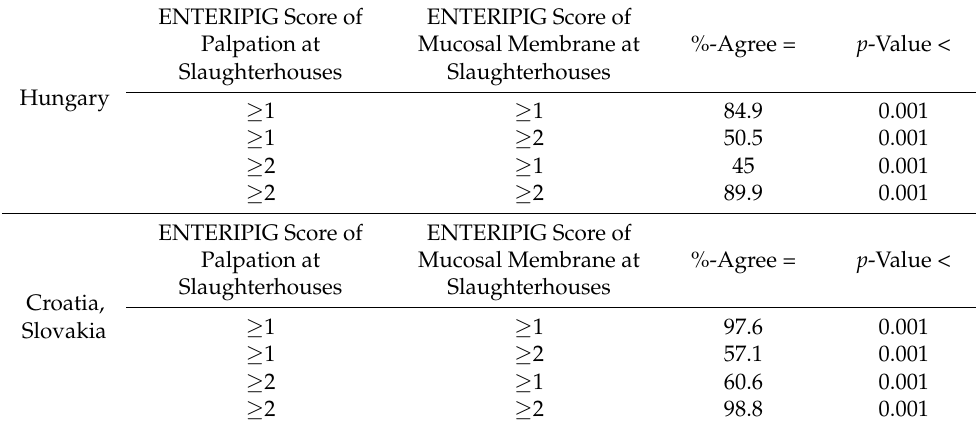
Table 3. VP vs. Mucosa